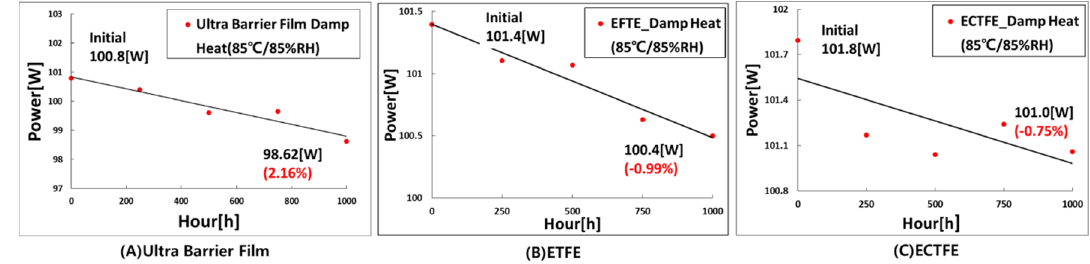
Figure 7. The result of the damp heat test of the PV module with the film applied to the front surface ( A ) Ultra-barrier film ( B ) ETFE and ( C ) ECTFE.